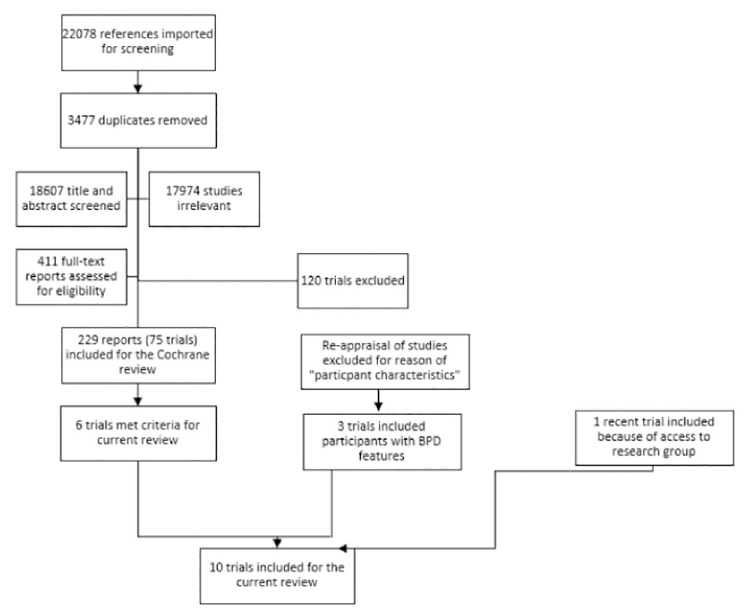
Fig 1. PRISMA flow